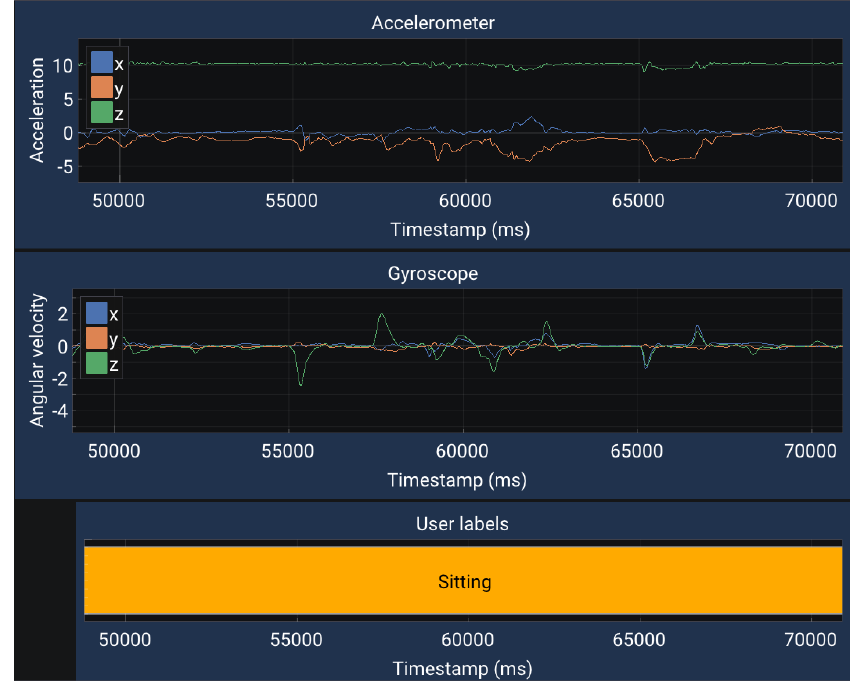
Figure A4. 20 s extracted from SITTING session of subject T1.